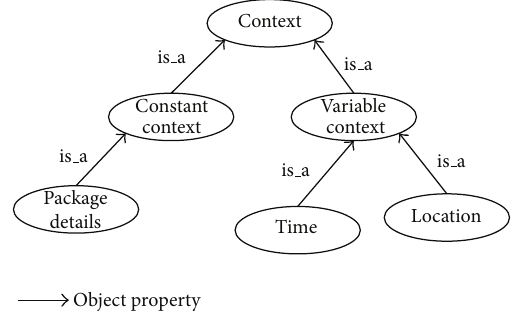
Figure 1: Ontology tree of context class.